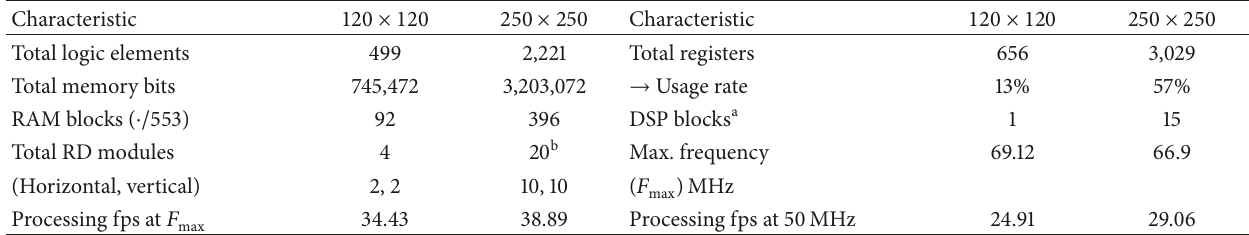
Table 1: FPGA synthesis results of the core